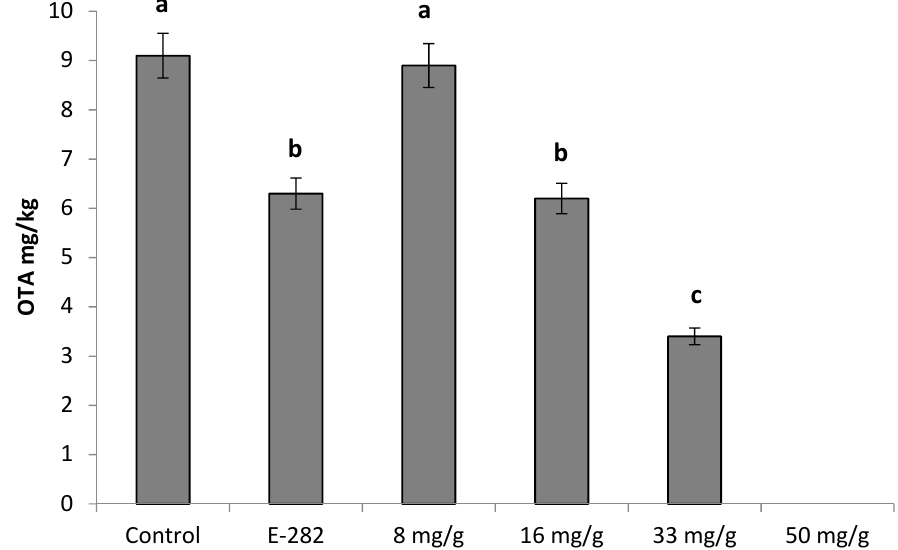
Figure 4. OTA produced by P. verrucosum growth in pita breads stored during 7 days in a plastic tray containing a small sachet sealed with 8, 16, 33 and 50 mg/g of oriental mustard flour sauce. Different letters show significant differences between treatments ( p ≤ 0.05).